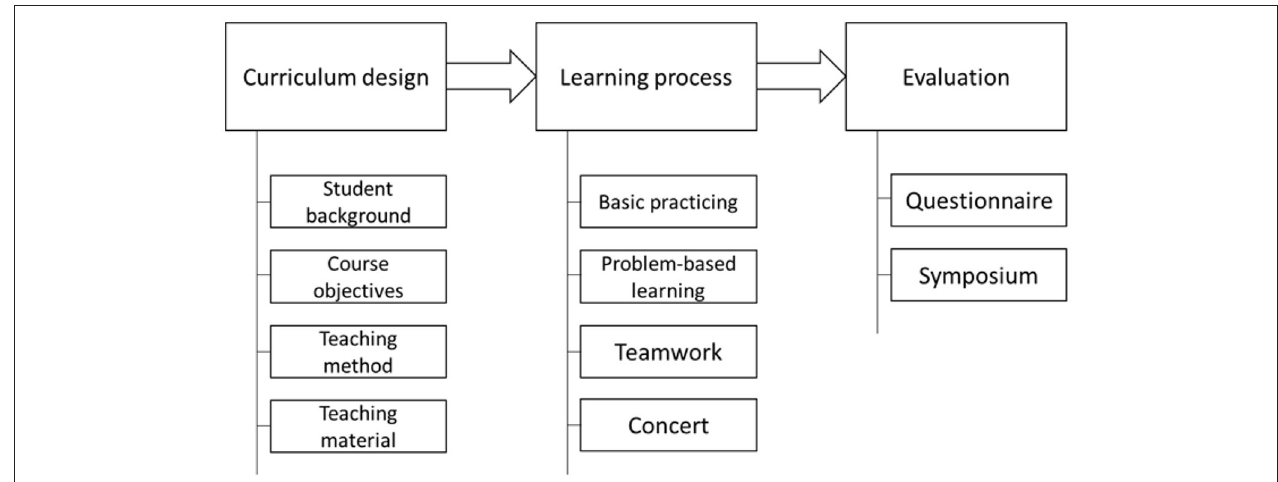
FIGURE 1 | Keyboard music learning course